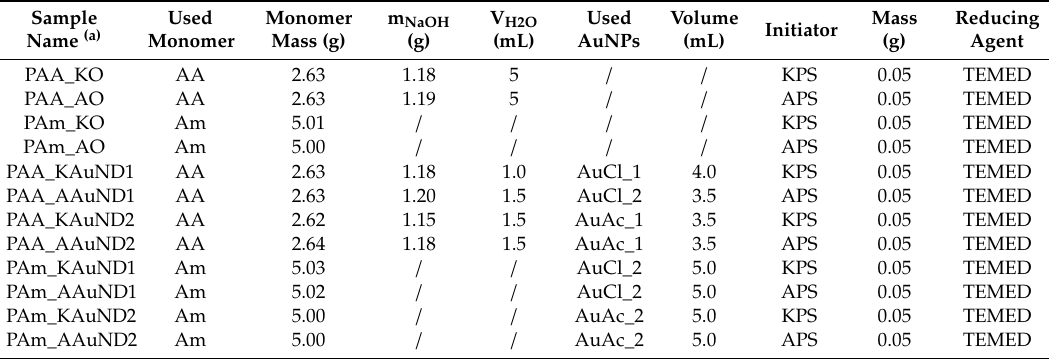
Table 2. Composition data for prepared control samples and polyacrylate-AuNPs’